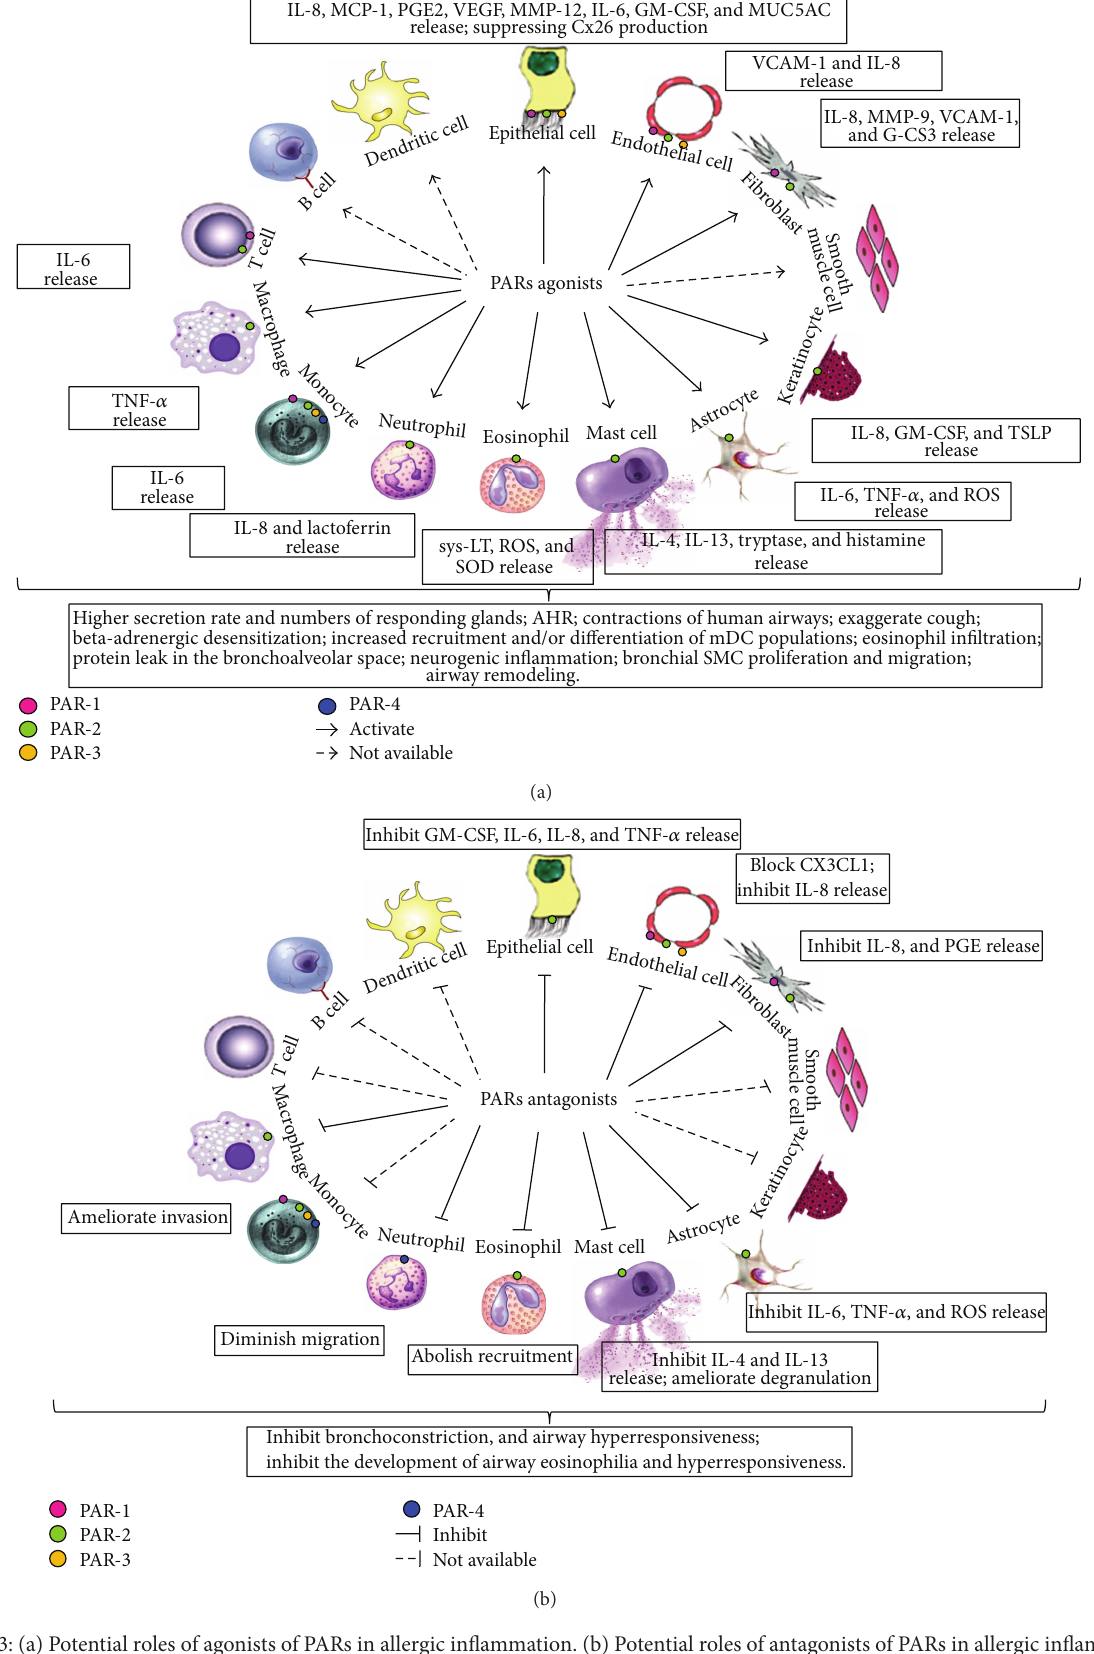
Figure 3: (a) Potential roles of agonists of PARs in allergic inflammation. (b) Potential roles of antagonists of PARs in allergic